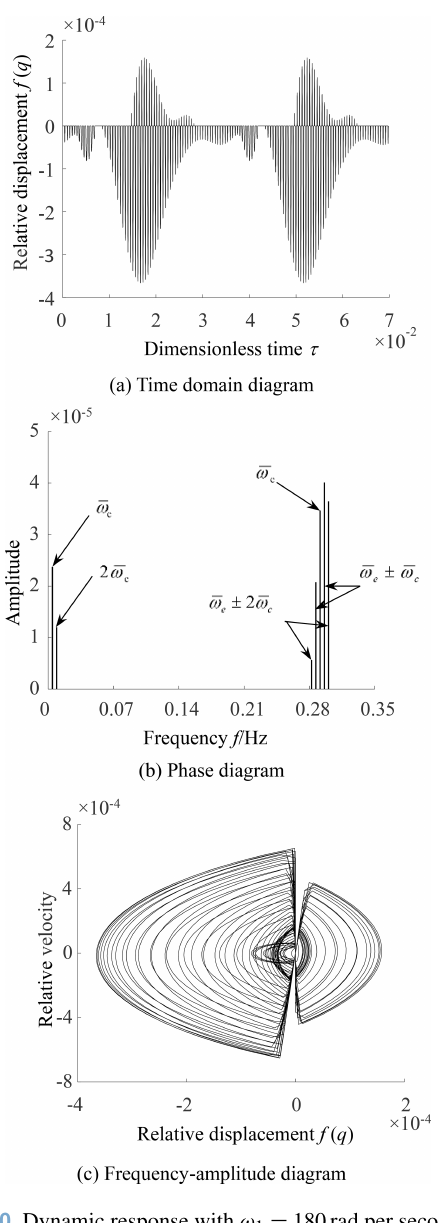
Figure 10. Dynamic response with ω 1 = 180rad per second.